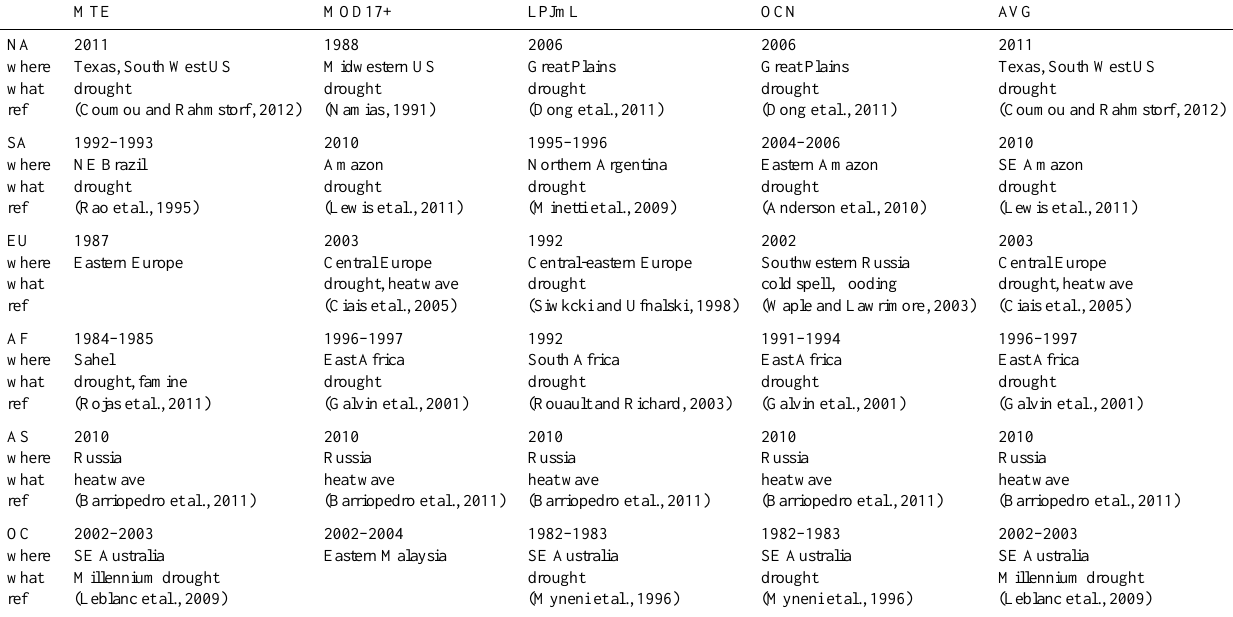
Figure 10. Percentage of extreme p values ( p < 0 . 1) of the 200 largest negative 1st-percentile GPP extreme events for each of the six continents, all four data sets and the variables high and low temperature ( T , red and blue), high and low precipitation ( P , green and purple), low water availability (drought, orange), and high burned area or fire emissions (fire, yellow). The horizontal line depicts the significance threshold (0.1), that is, the percentage of events which are expected to have p values below 0.1 if the data were random. The last bar (rest, brown) depicts the fraction of events that could not be attributed to any of the former variables. Table 1. Approximate location, timing and reference (ref) for the largest negative 1st-percentile GPP extreme events from each of the five data sets MTE, MOD17+, LPJmL, OCN and AVG on each